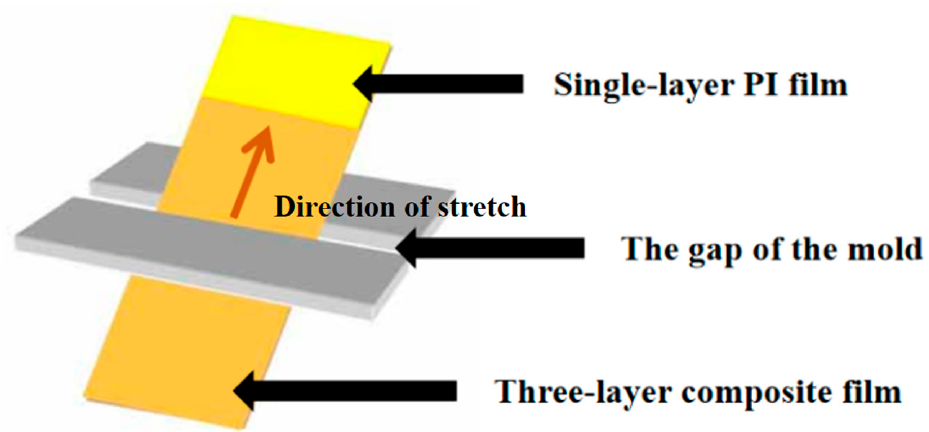
Figure 1. Schematic diagram of the procedure used to prepare the composite films.